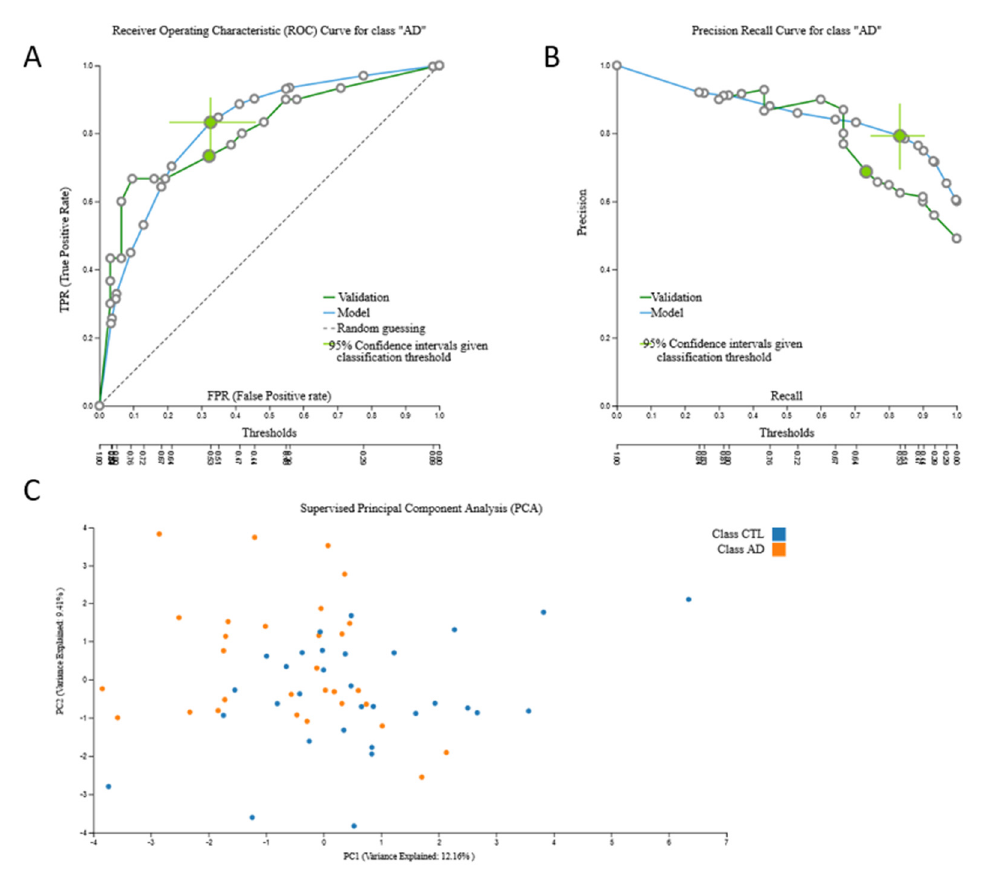
Figure 4. The 38,327 ‐ feature mRNA ‐ transcriptomic sub ‐ dataset (train) signature performance, selected predictors and model inspection: ( A ). Receiver Operating Characteristic (ROC) Curve for AD class, ( B ). Precision ‐ recall plot, ( C ). Probabilities density plot, ( D ). Supervised Principal Component Analysis plot depicting discrimination between AD patients and age–sex matched cognitively healthy individuals, ( E ). Cumulative feature importance plot of the 25 mRNA predictors of the signature.